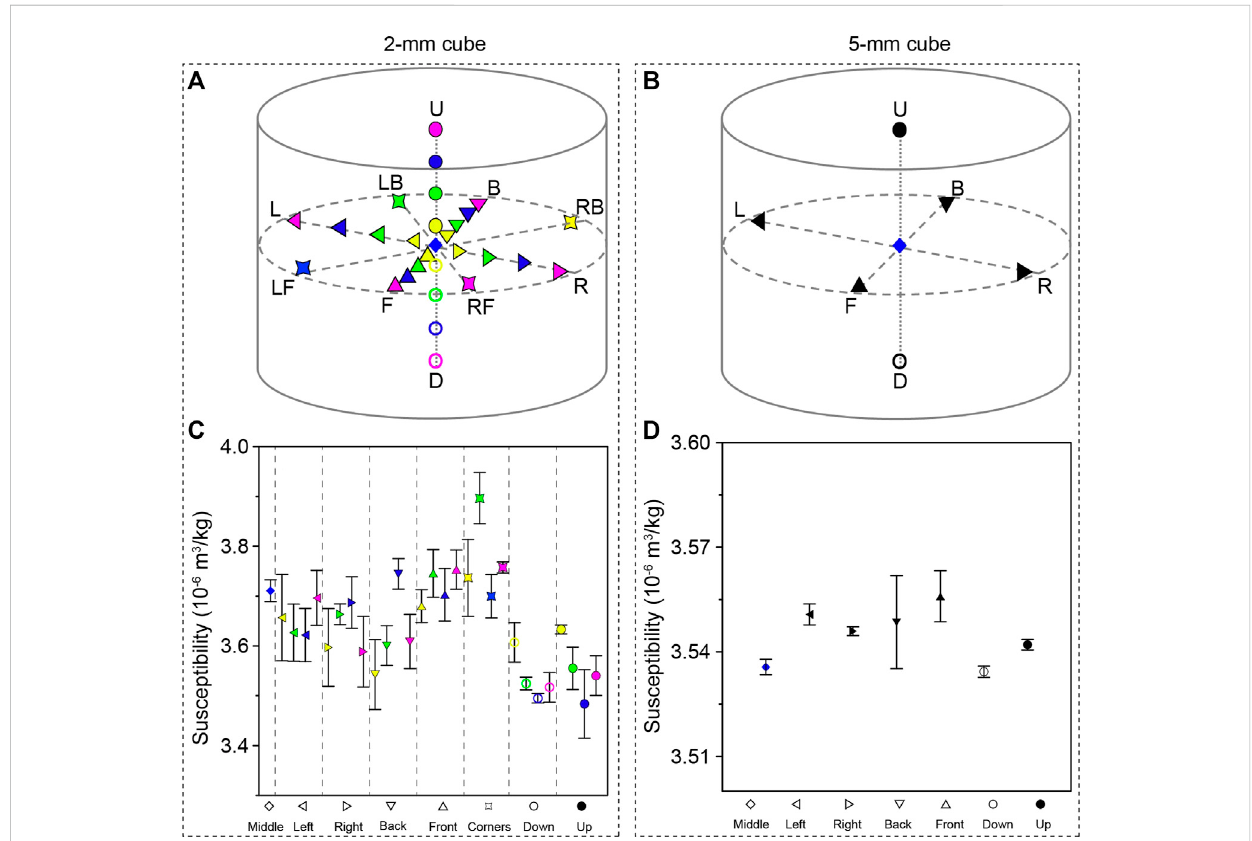
FIGURE 3 (A) Sketch map of measurement position of a 2-mm basalt cube, moving 2,4, 6, 8 mm from middle towards up (U), down (D) , left (L), right (R), back (B) , and forth (F) respectively. Four corner positions about 11 mm far from the center of left back (LB), left front (LF), right back (RB), and right front (RF) werealsomeasured. (B) Sketchmapofmeasurementpositionofa5-mmbasaltcube.Eachendpositionofthreeorthogonallinesisabout6 mmfromthe center. (C) Mean magnetic susceptibility and its standard deviation at different positions of the 2-mm cube. (D) Mean magnetic susceptibility and its standard deviation at different positions of the 5-mm cube.